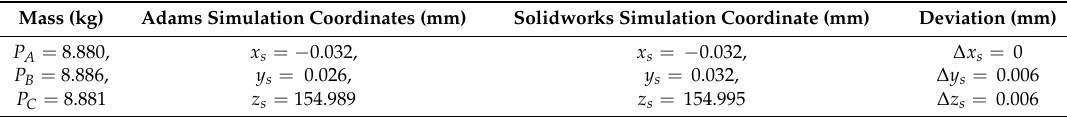
Table 7. Simulation measurement results of the centroid of the standard workpiece in adams.